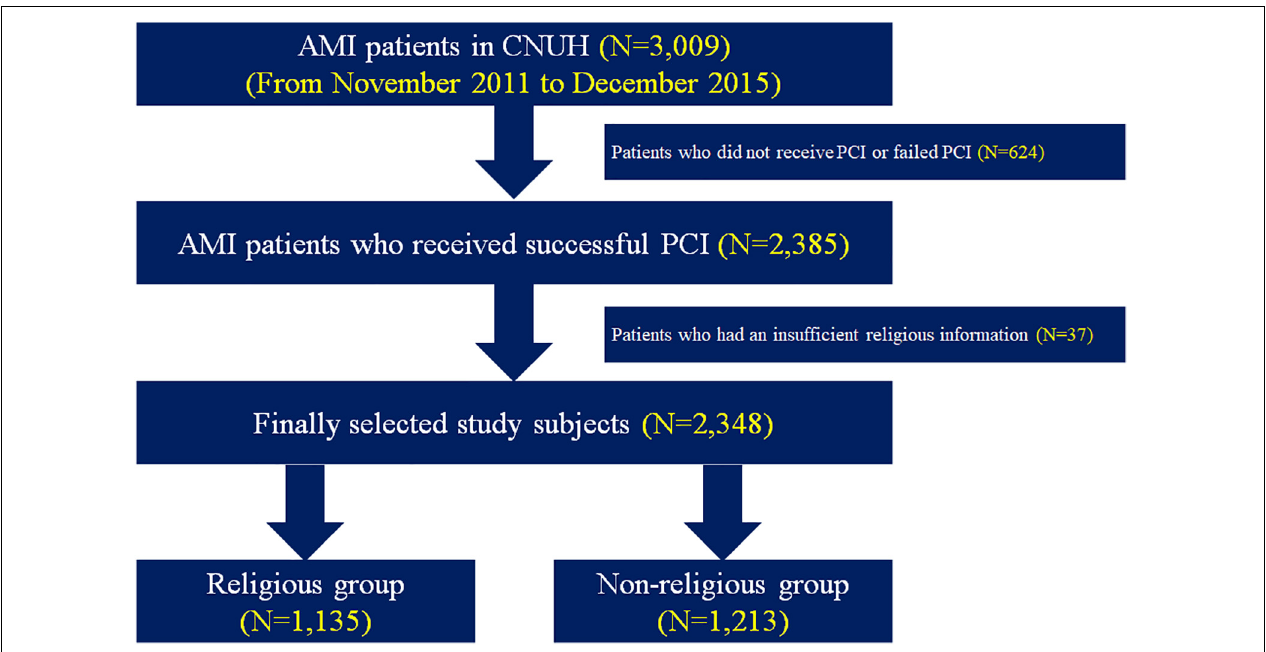
FIGURE 1 | Flowchart of study population. AMI, acute myocardial infarction; CNUH, Chonnam National University Hospital; and PCI, percutaneous coronary intervention.